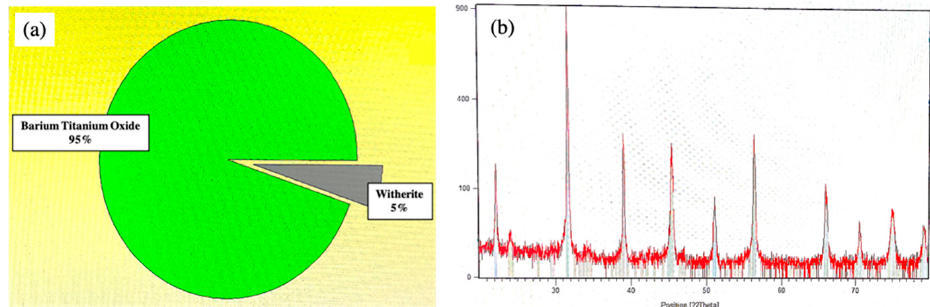
Figure 3. ( a ) Quantitative analysis and ( b ) peak matching of the BaTiO 3 powder using the X’Pert HighScore Plus program.